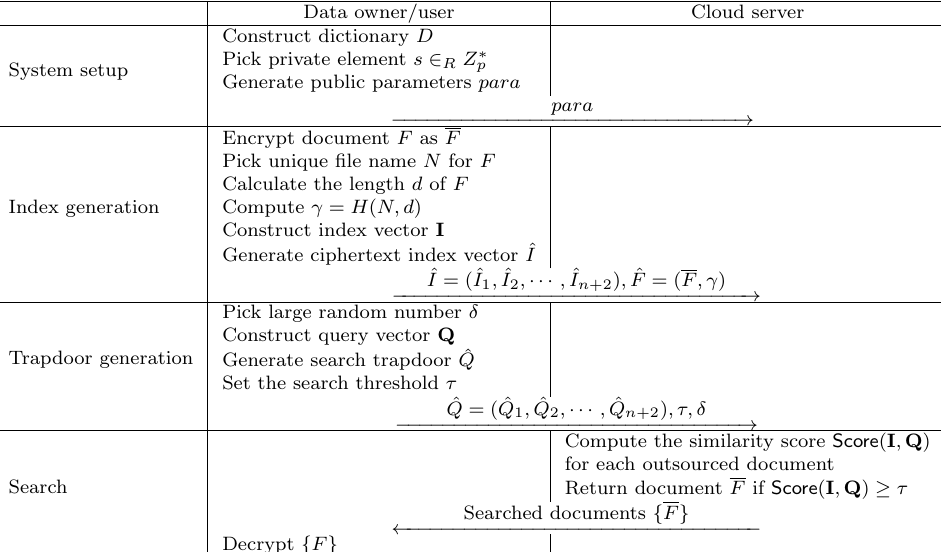
Fig. 3 The execution process of basic PRMS scheme Fig. 2 The execution process of basic PRMS scheme